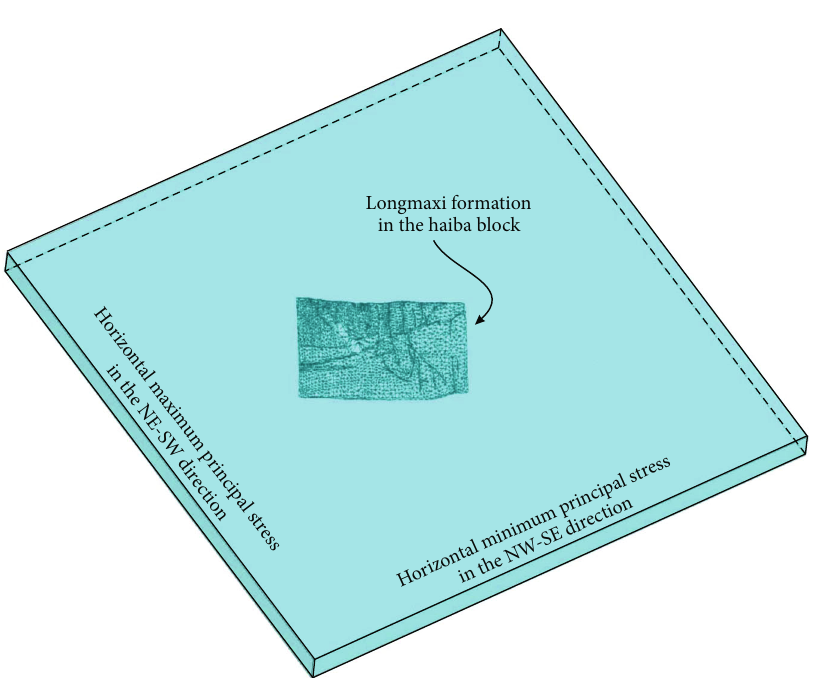
Figure 7: Simpli fi ed nested model of the Longmaxi Formation in the Haiba Block.